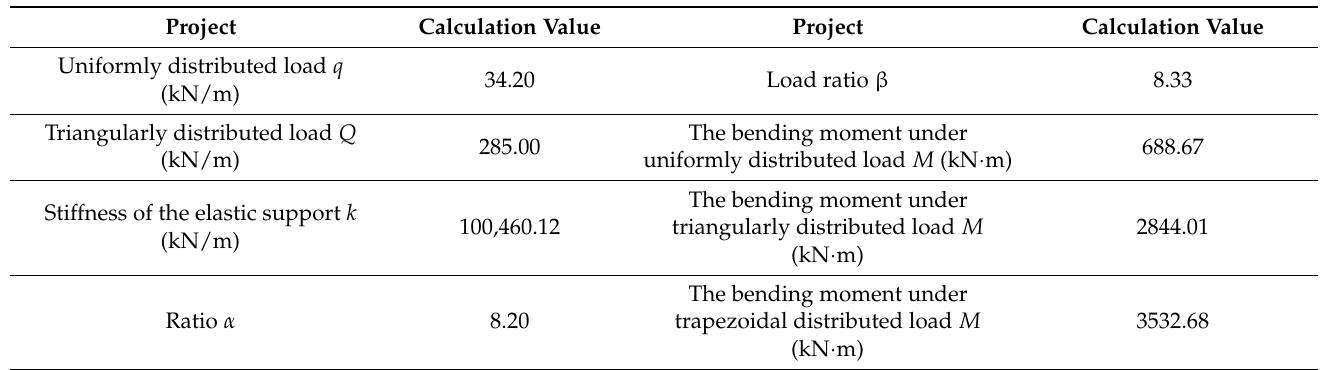
Table 1. Calculation sheet of analytic solutions by theoretical